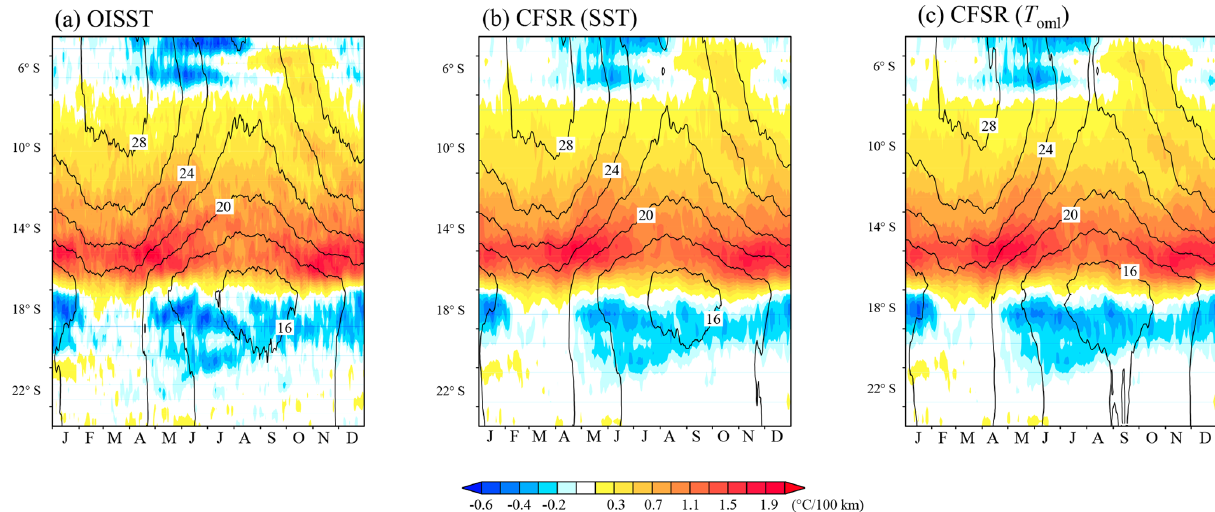
Figure 2. Climatological seasonal cycle of the temperature (contour) and its meridional gradient averaged between 10 and 12 ◦ E for (a) SST of OISST, (b) SST of CFSR, and (c) OML-mean potential temperature of